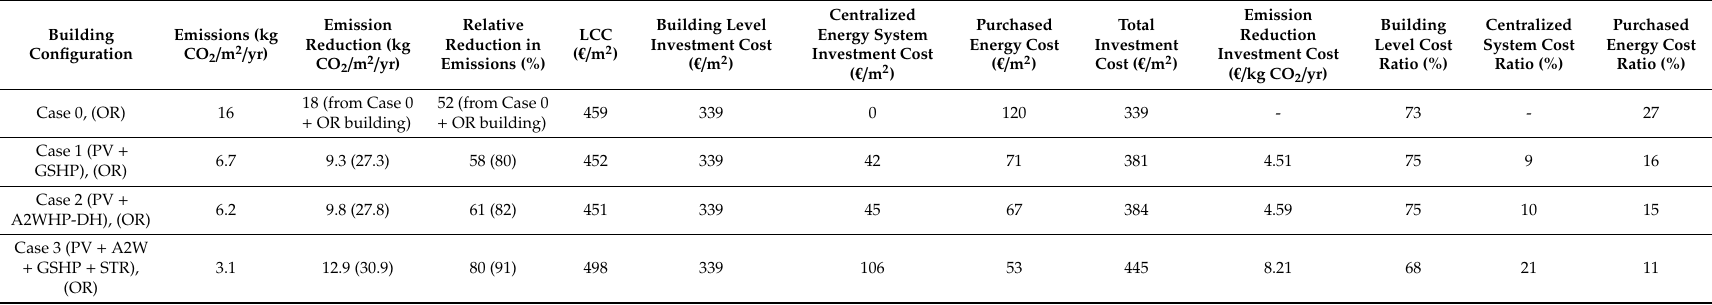
Table 5. Emissions and cost comparison of the proposed centralized community-level energy district heating systems (Cases 1, 2, and 3) integrated with deep renovated (DR) old residential buildings in the district and city-level reference district heating system (Case